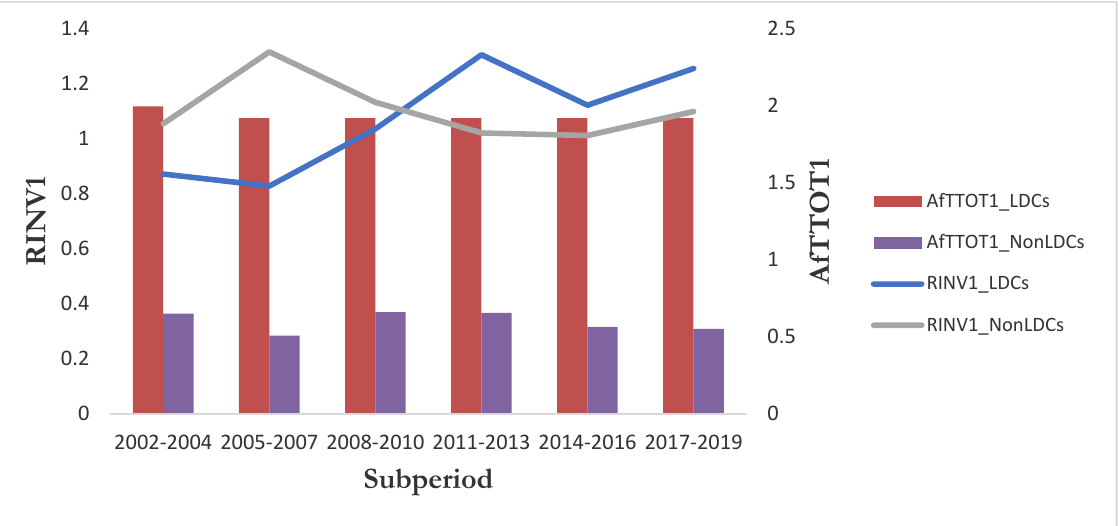
Figure 2. Total AfT flows and remittance-oriented investment flows over the subsamples of LDCs and non-LDCs. Source: Author. Note: The variables “RINV1” and “AfTTOT1” are respectively the share of remittance-oriented investment flows in GDP and the share of total AfT flows in GDP, both expressed in percentages, for the sake of the graphical analysis.